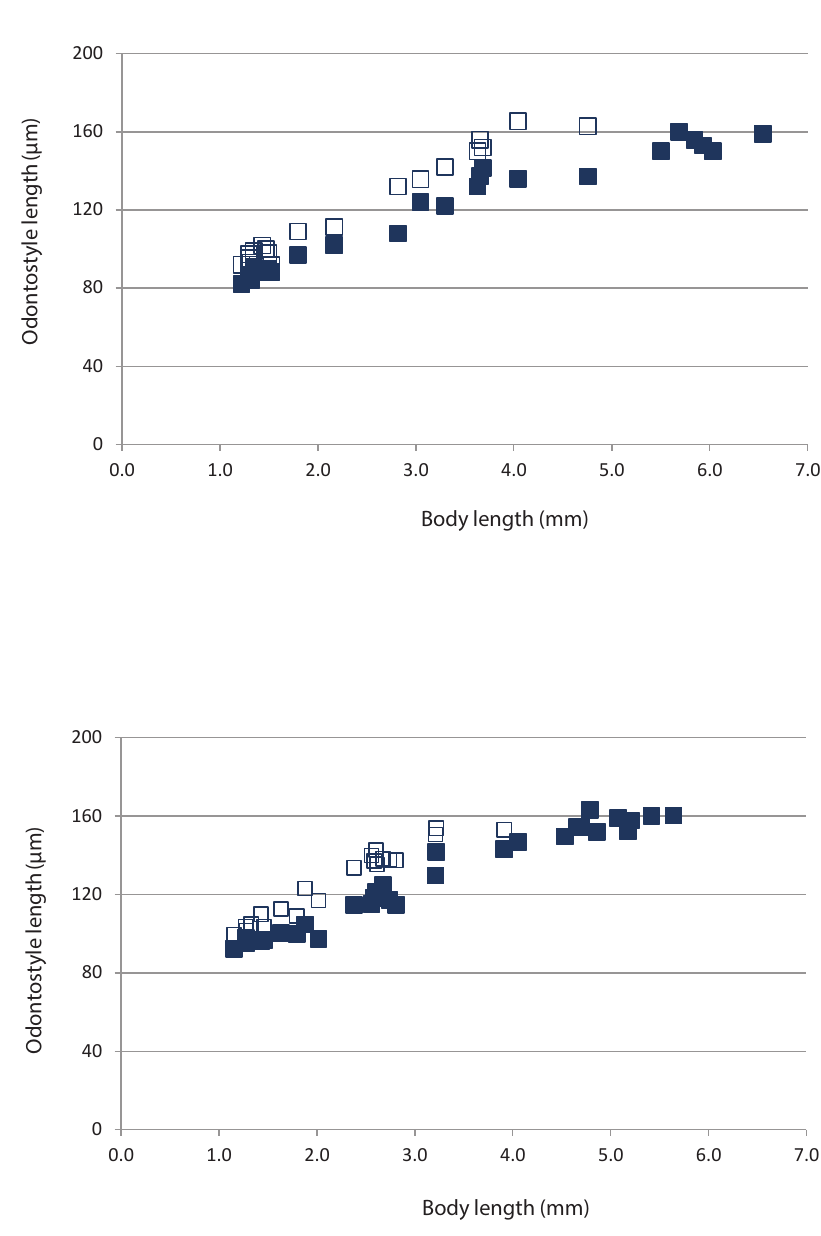
Figure 7. Scatter plot of odontostyle ( ■ ) and replacement odontostyle ( □ ) against body length of Lon- gidorus piceicola juveniles (J1 to J4) and females from A Cernica forest, Ilfov county and B Bran locality, Braşov